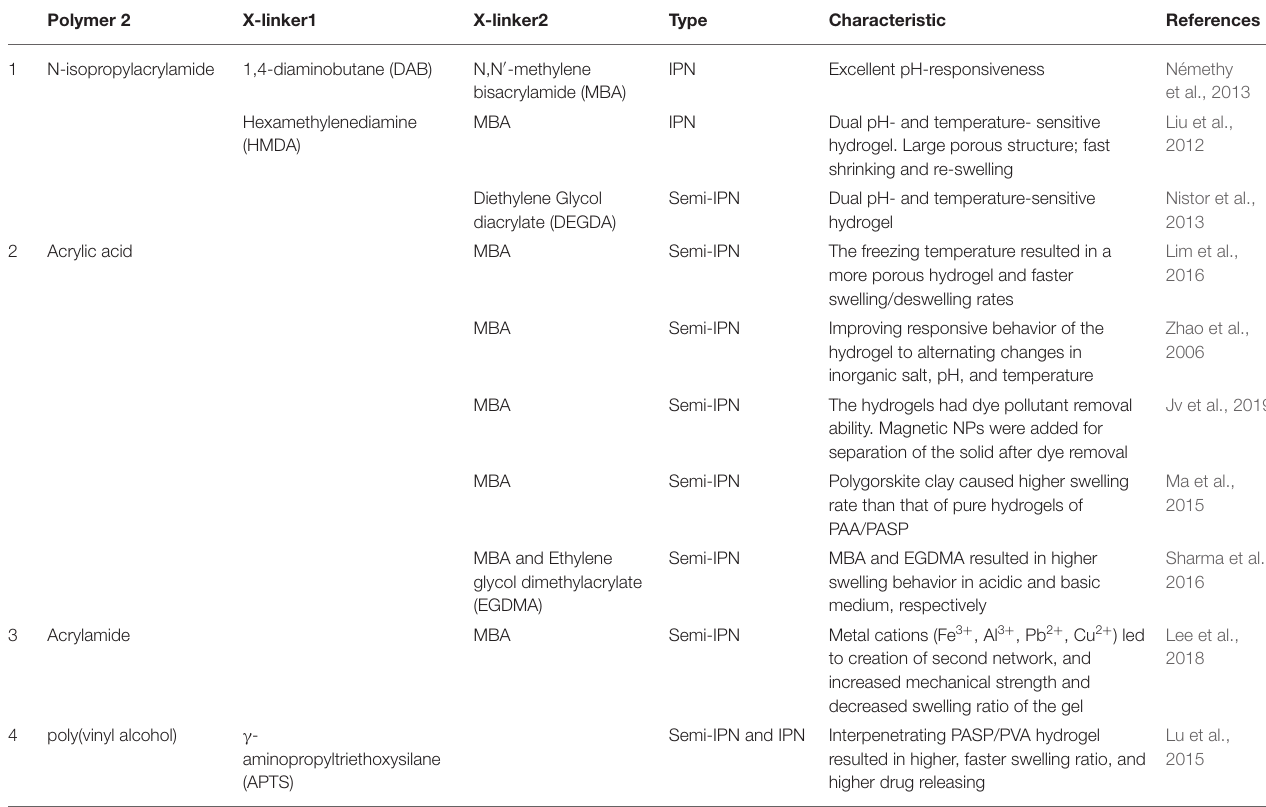
TABLE 1 | PASP-based IPN and semi-IPN with different polymers (denoted as polymer